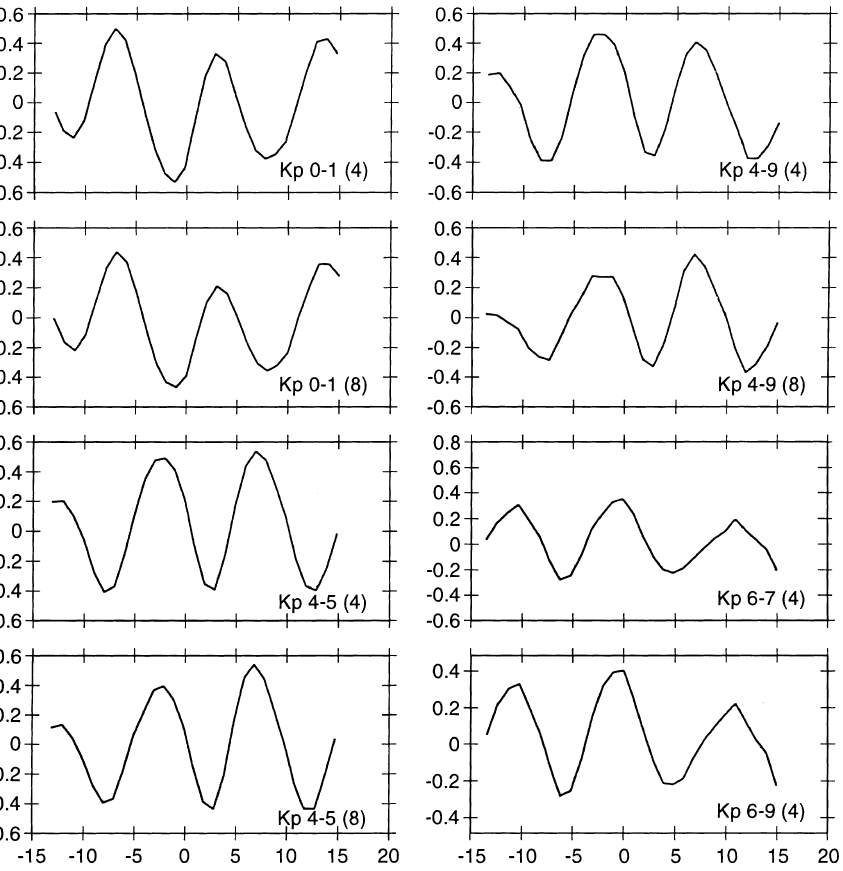
Fig. 5. Lagged correlations between annual mean sunspot number and the occurrence frequencies of Kp in di(cid:128)erent categories and lengths of consecutive intervals with same magnitude. Positive lag (in years) corresponds to the correla- tion between current annual values of Kp and annual Rz